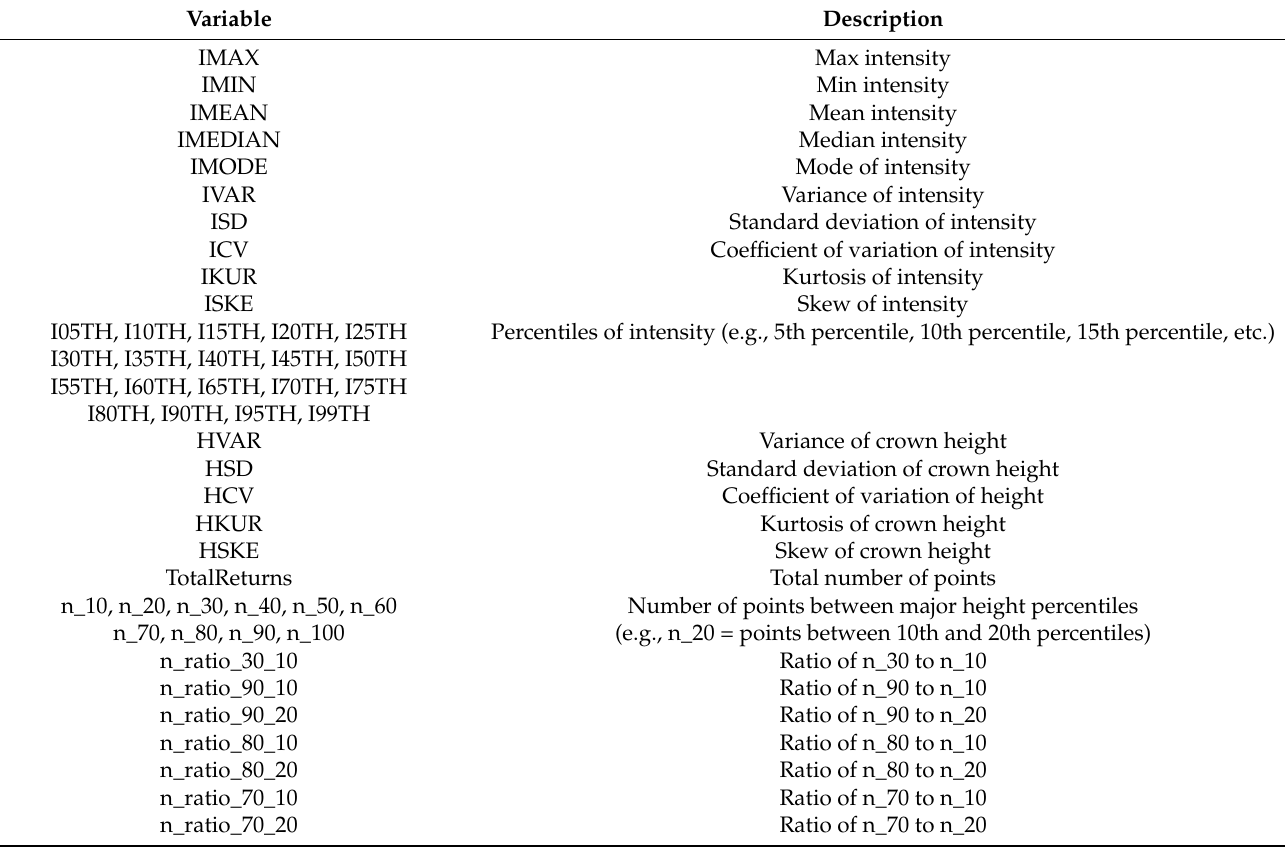
Table 3. Structural features extracted from lidar point